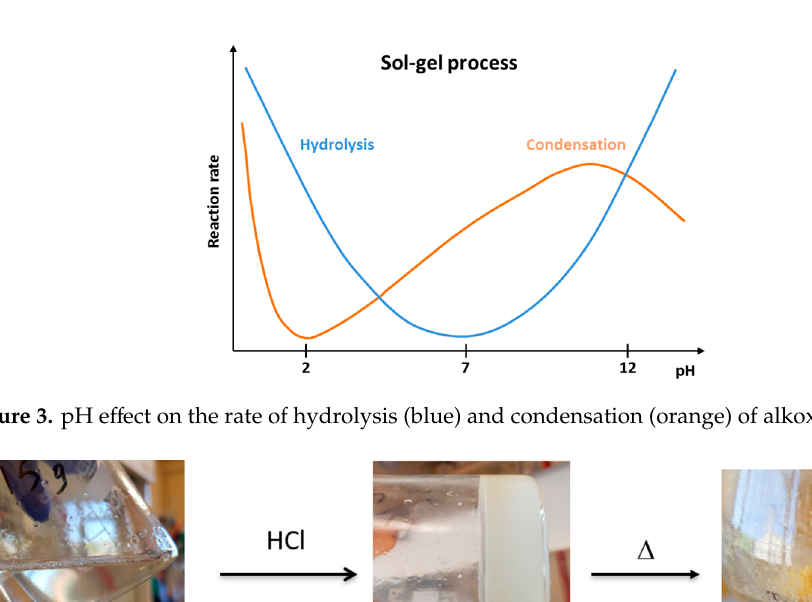
Figure 3. pH effect on the rate of hydrolysis (blue) and condensation (orange) of alkoxysilanes [98].